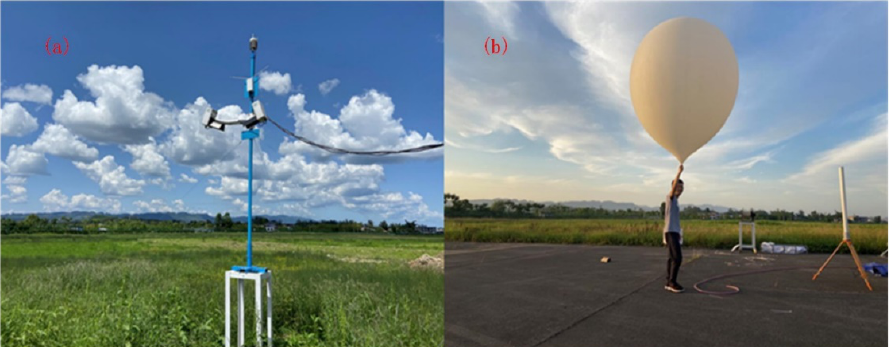
Table 2. The main technical parameters of the microwave radiometer.